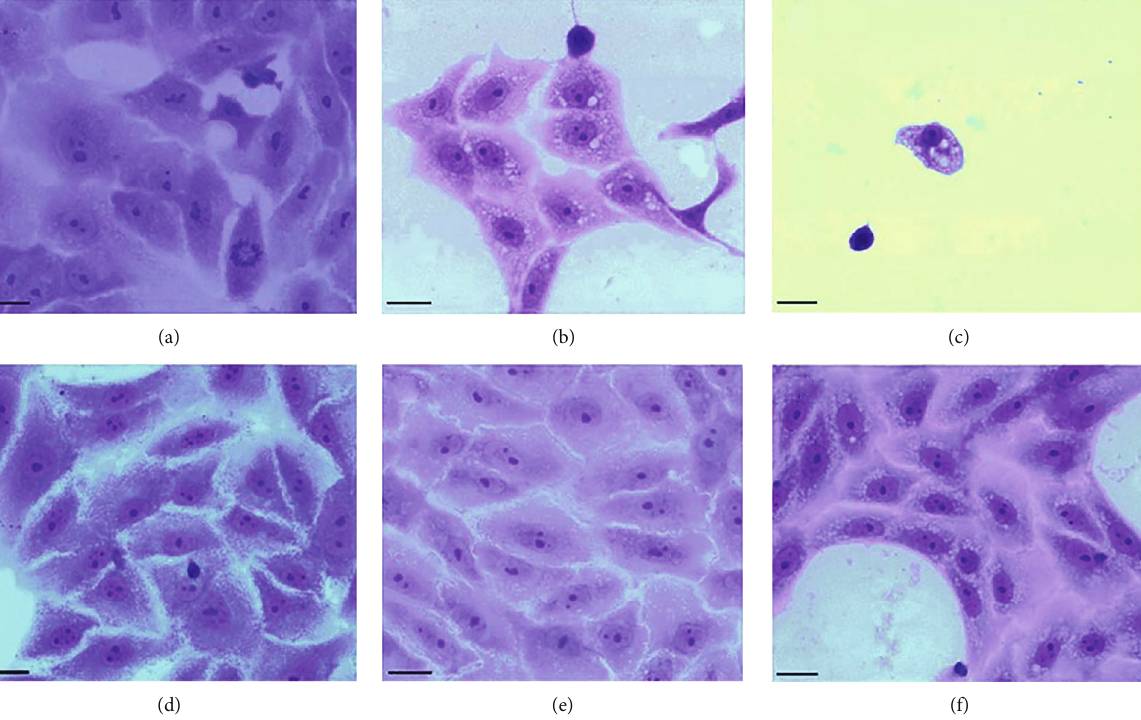
Figure 5: General morphology study by bright- fi eld microscopy and toluidine blue staining of cultures exposed to butylhydroxyanisole and/ or propylparaben for 24h. 20 μ mbar.